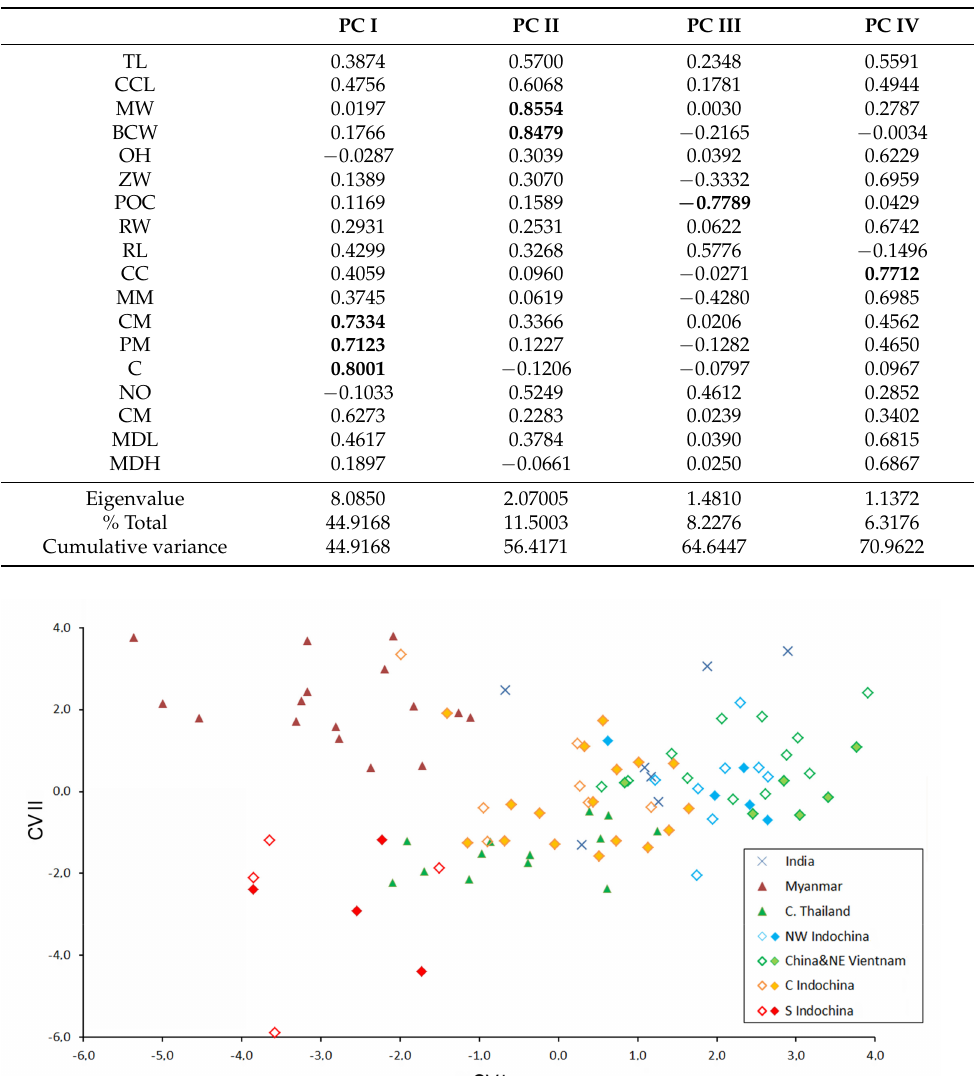
Table 4. Results of PCA applied to specimens of the Hipposideros pomona/gentilis species complex based on 18 cranial measurements: factor loadings, eigenvalues, and percentage of total variance. See text for measurement abbreviations. Factor loadings over 0.7 are highlighted in boldface type.